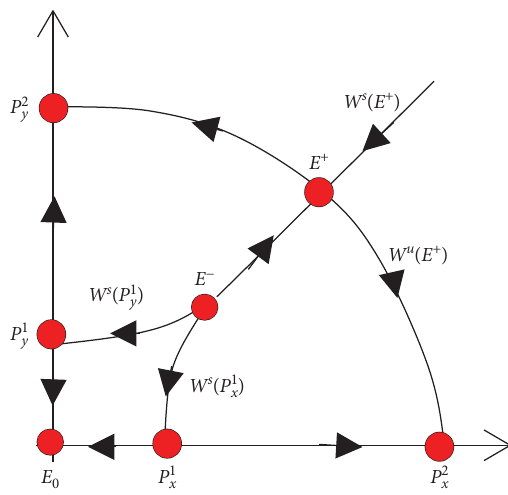
Figure 8: All invariant manifolds of Theorem 10.